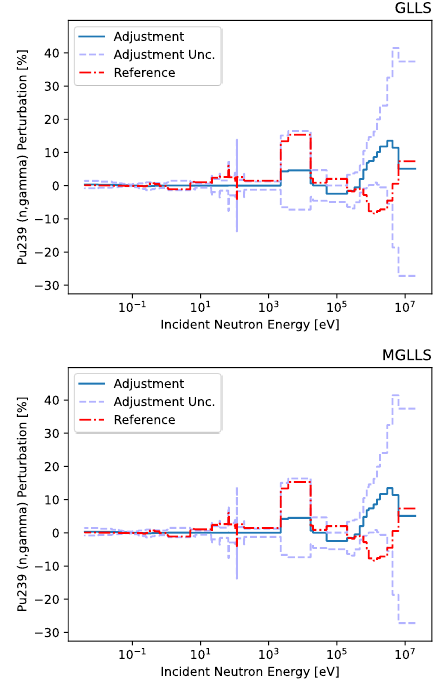
Fig. 3 Comparison of adjusted nuclear data